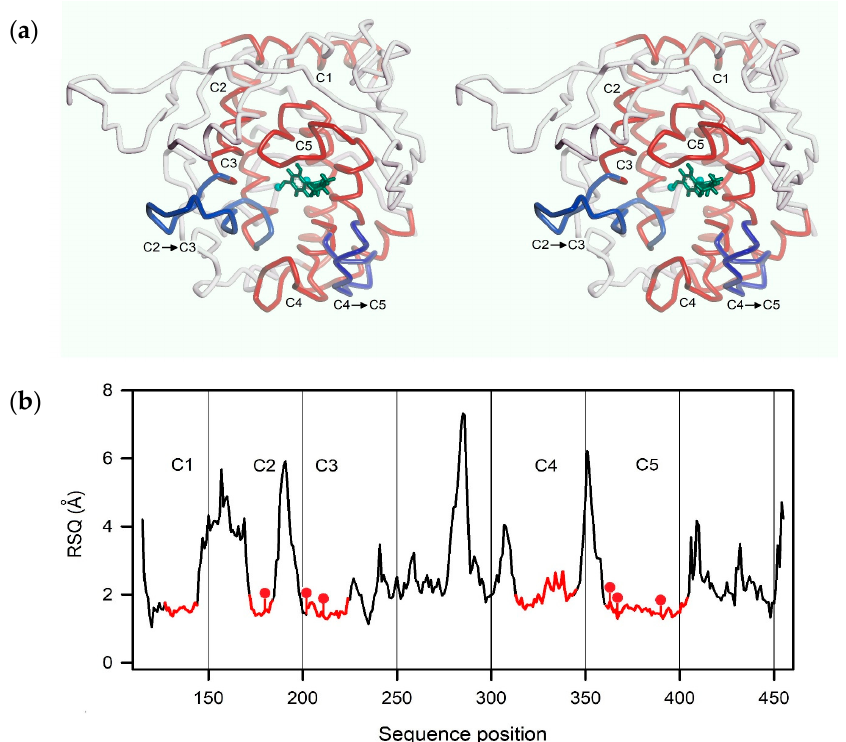
Figure 3. Structure of the homology model of hTyr used for docking simulations. ( a ) Backbone trace of the model (stereo representation). Core segments are highlighted in red, two relevant loops in blue (see text). The position of the active site is indicated by two copper ions (cyan balls) and a docked ligand (green); ( b ) Degree of structural conservation (expressed as residue-specific quality of an I-Tasser model (RSQ), see text) of each residue between model and templates. The highly conserved core segments C1 to C5 are shown in red.